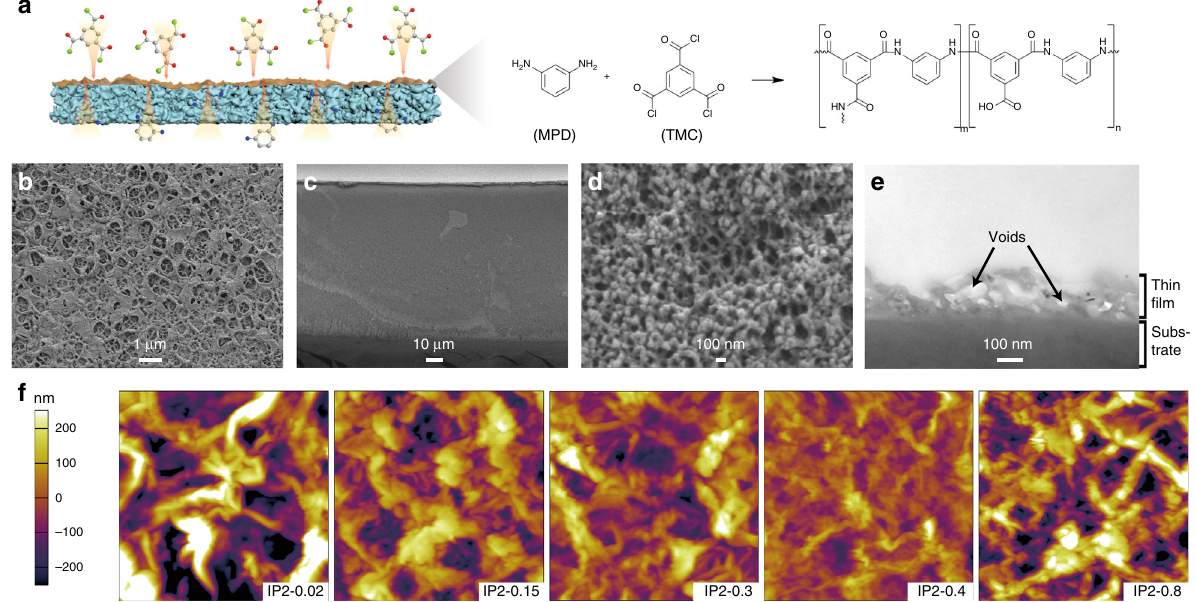
Fig. 1 The structure and morphology of thin- fi lm composite membranes and substrate. a Schematic illustration of the mechanism of interfacial polymerization. b Surface morphology of IP2-0.15. c , d Cross-section morphology of IP2-0.15. e TEM image of the cross-section of IP2-0.15. f AFM images of TFCMs. The image size is 5 × 5 μ